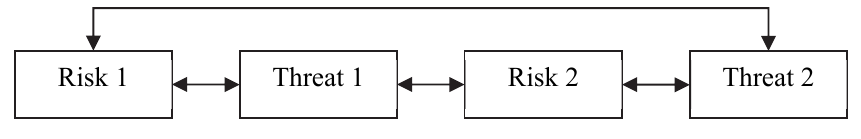
Fig. 2. Interaction of risk and threat